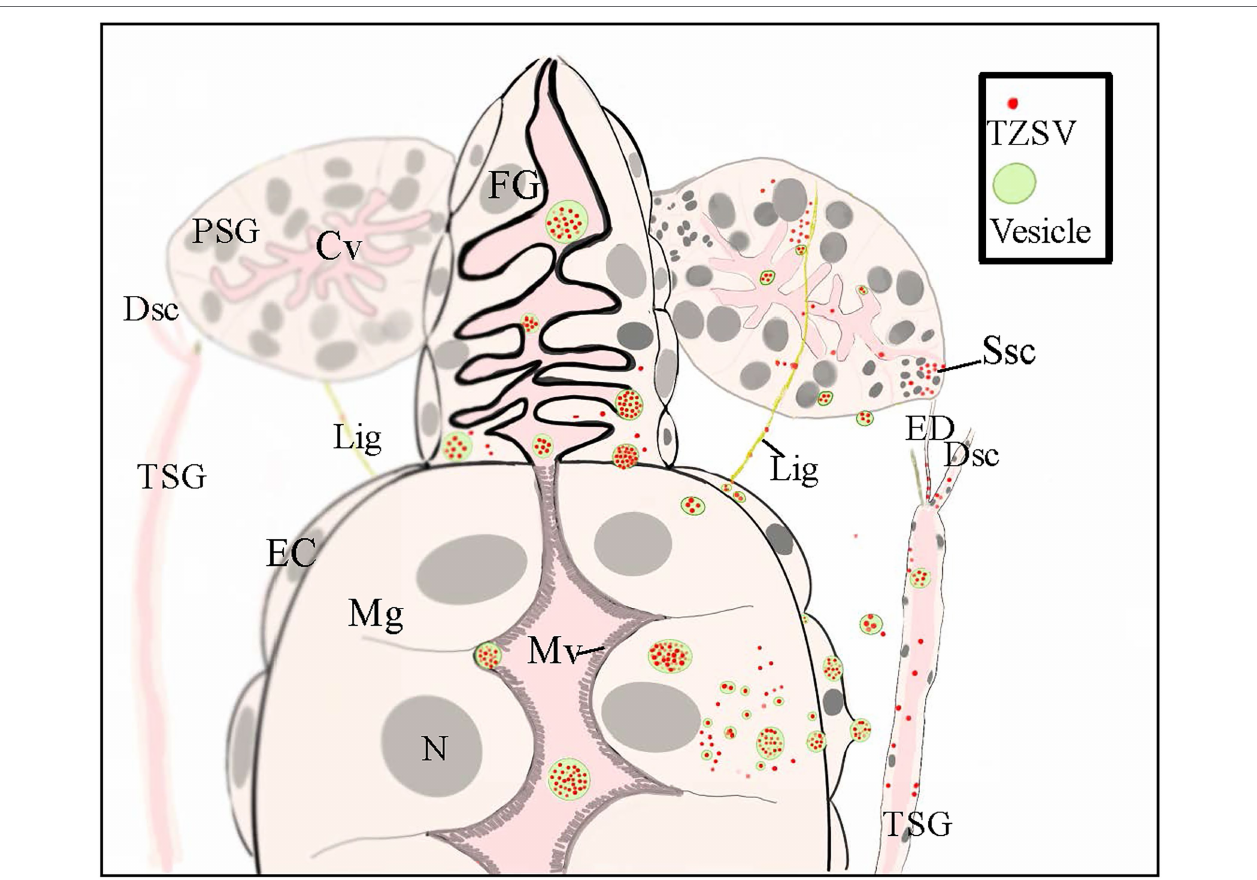
FIGURE 4 | A schematic illustration showing the internal anatomy of the front part of the digestive system of nymphs of a Frankliniella occidentalis nymph and the connections between the primary salivary glands (PSGs) and other parts of the digestive system. The three postulated tomato zonate spot virus (TZSV) transmission routes are also depicted. (1) At the anterior-most region of the midgut, two slim ligaments connect each PSG and serve as a conduit for viral movement from the epitheliomuscular cells of the midgut to the secretory cells of PSGs. (2) TZSV particles can also enter epithelial cells of the foregut and midgut via endocytosis, replicate in the cells, or move directly into the epitheliomuscular cells and then the hemolymph before arriving at the secretory cells of PSGs. (3) The efferent duct connects the tubular salivary gland (TSG) with the corresponding PSG and serves as a conduit for viral movement from the TSG to the senescent secretory cells of PSGs. Abbreviations: CL, cistern lumen; DSC, deferent salivary canal; ED, efferent duct; Fg, foregut; Lig, ligament; Mg, midgut; EC: epitheliomuscular cell; Mv, microvillus; N, nucleus; Ssc, senescent secretory cell; PSG, primary salivary gland; TSG, tubular salivary